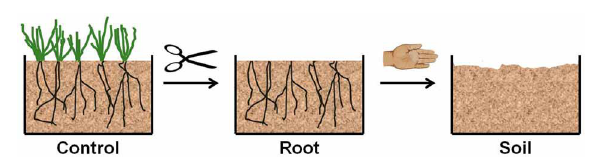
FIGURE 1 | An illustration of the experimental manipulations of heath mesocosms. The control mesocosms had intact vegetation. In the root mesocosms all aboveground vegetation was cut with scissors. In the soil mesocosms aboveground vegetation was cut and roots were removed by